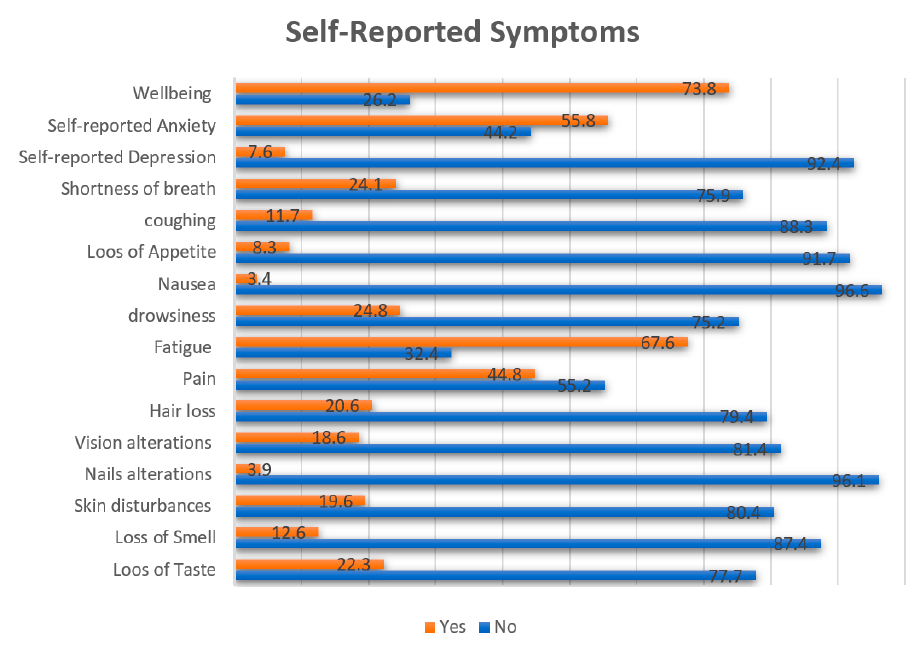
Figure 1. Self-reported symptoms . Values are presented in percentages.